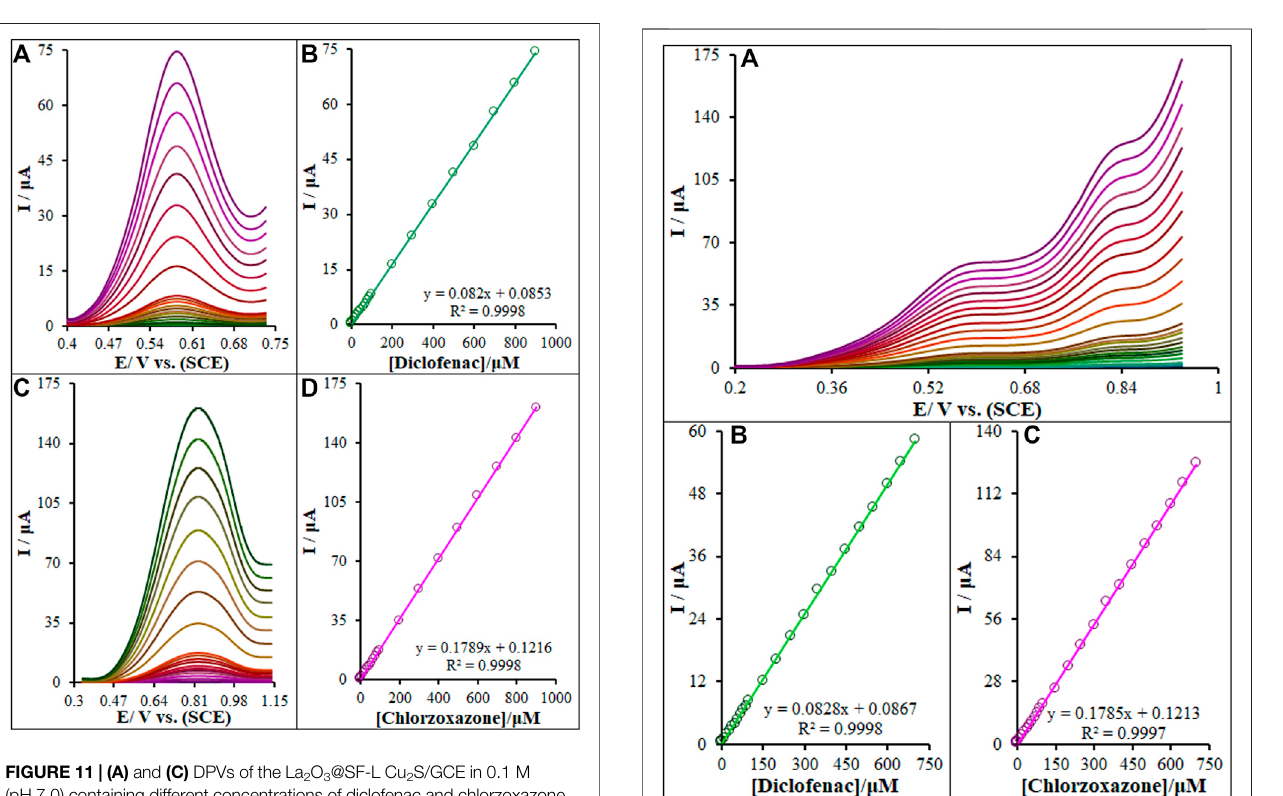
Figure 8 . A slight elevation occurred in the peak currents of until 7.0 and then reduction. The pH value of 7.0 resulted in